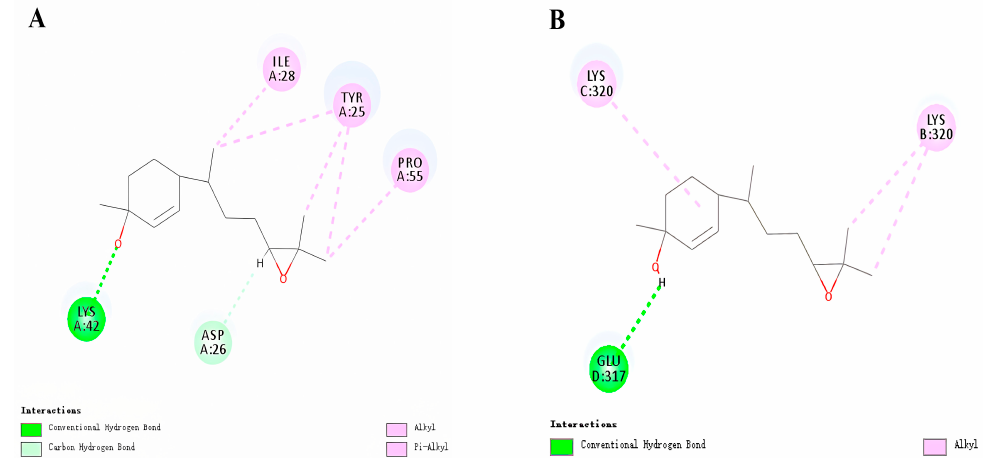
Figure 3. Molecular docking schematic of Hh CSP5 docking.Diagram of the interactions of (3 S ,6 S ,7 R ,10 S )-10,11-epoxy-1-bisabolen-3-ol and (3 R ,6 S ,7 R ,10 S )-10,11-epoxy-1-bisabolen-3-ol with key binding site residues of Hh CSP5 ( A , B ). Residues indicated in the figure have a distance to chemicals of <0.1 Å. Conventional hydrogen bonds and carbon hydrogen bonds are indicated in bright green and light green dashed lines, respectively. Alkyl and Pi-alkyls interactions are indicated in pink lines. The highest binding energy and highest interaction energy between Hh CSP5 and (3 R ,6 S ,7 R ,10 S )-10,11-epoxy-1-bisabolen-3-ol was 5.2411 and − 22.0535 kcal/mol, respec- tively. There was Alkyl force between LYS320 of Hh CSP5 and (3 R ,6 S ,7 R ,10 S